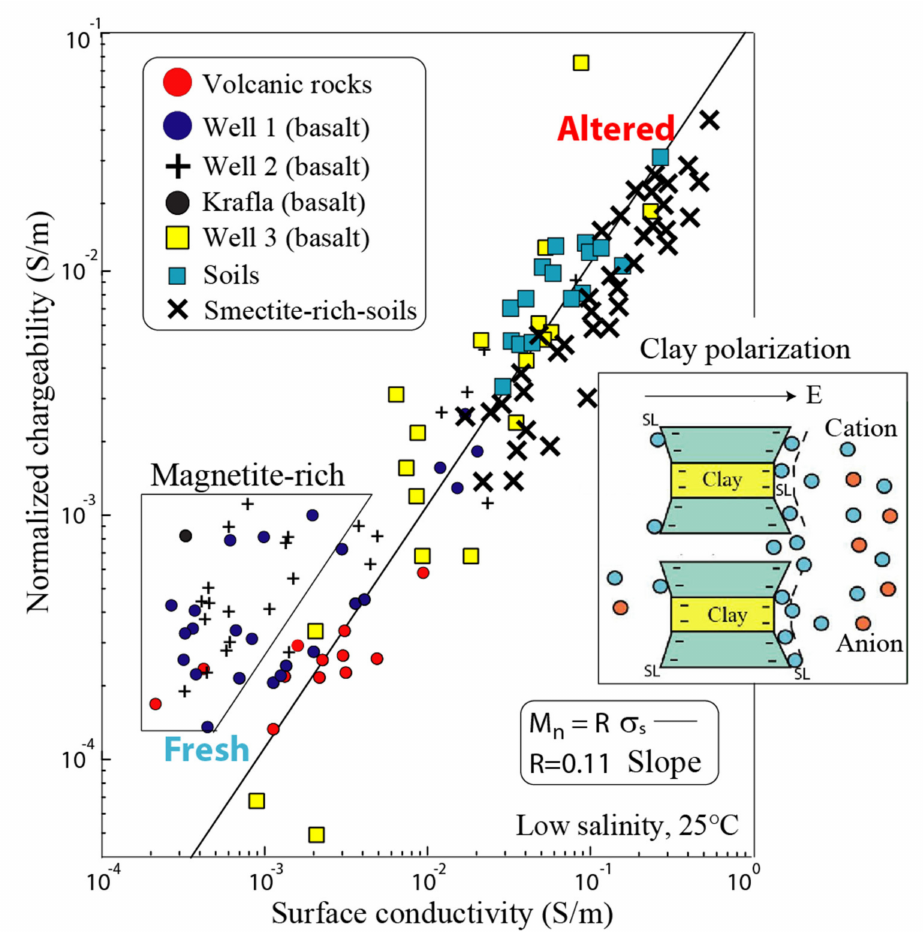
Figure 6. Relationship between normalized chargeability and surface conductivity, both being related to the electrical double layer coating the surface of the minerals (modified from Revil et al. [52]). Core samples with magnetite usually found near the ground surface in volcanoes have been excluded. The slope of the trend provides the value of the fundamental dimensionless number R, which is the ratio of the two mobilities involved in the normalized chargeability and surface conductivity, respectively (i.e., and B , respectively). E denotes the electrical field and SL denotes the Stern Layer. The cations are in blue and the anions in